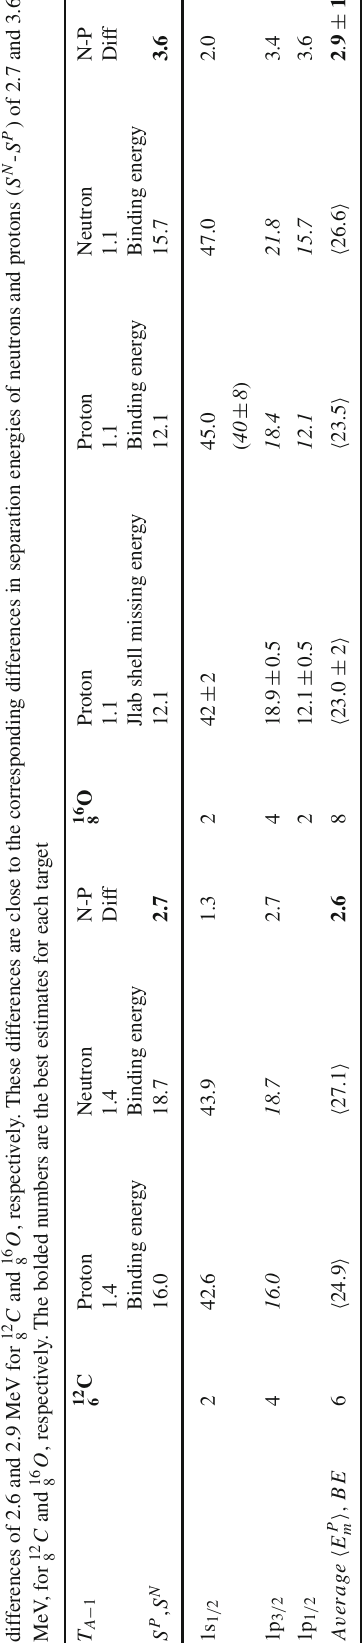
O as a function of E P m for p m = 8